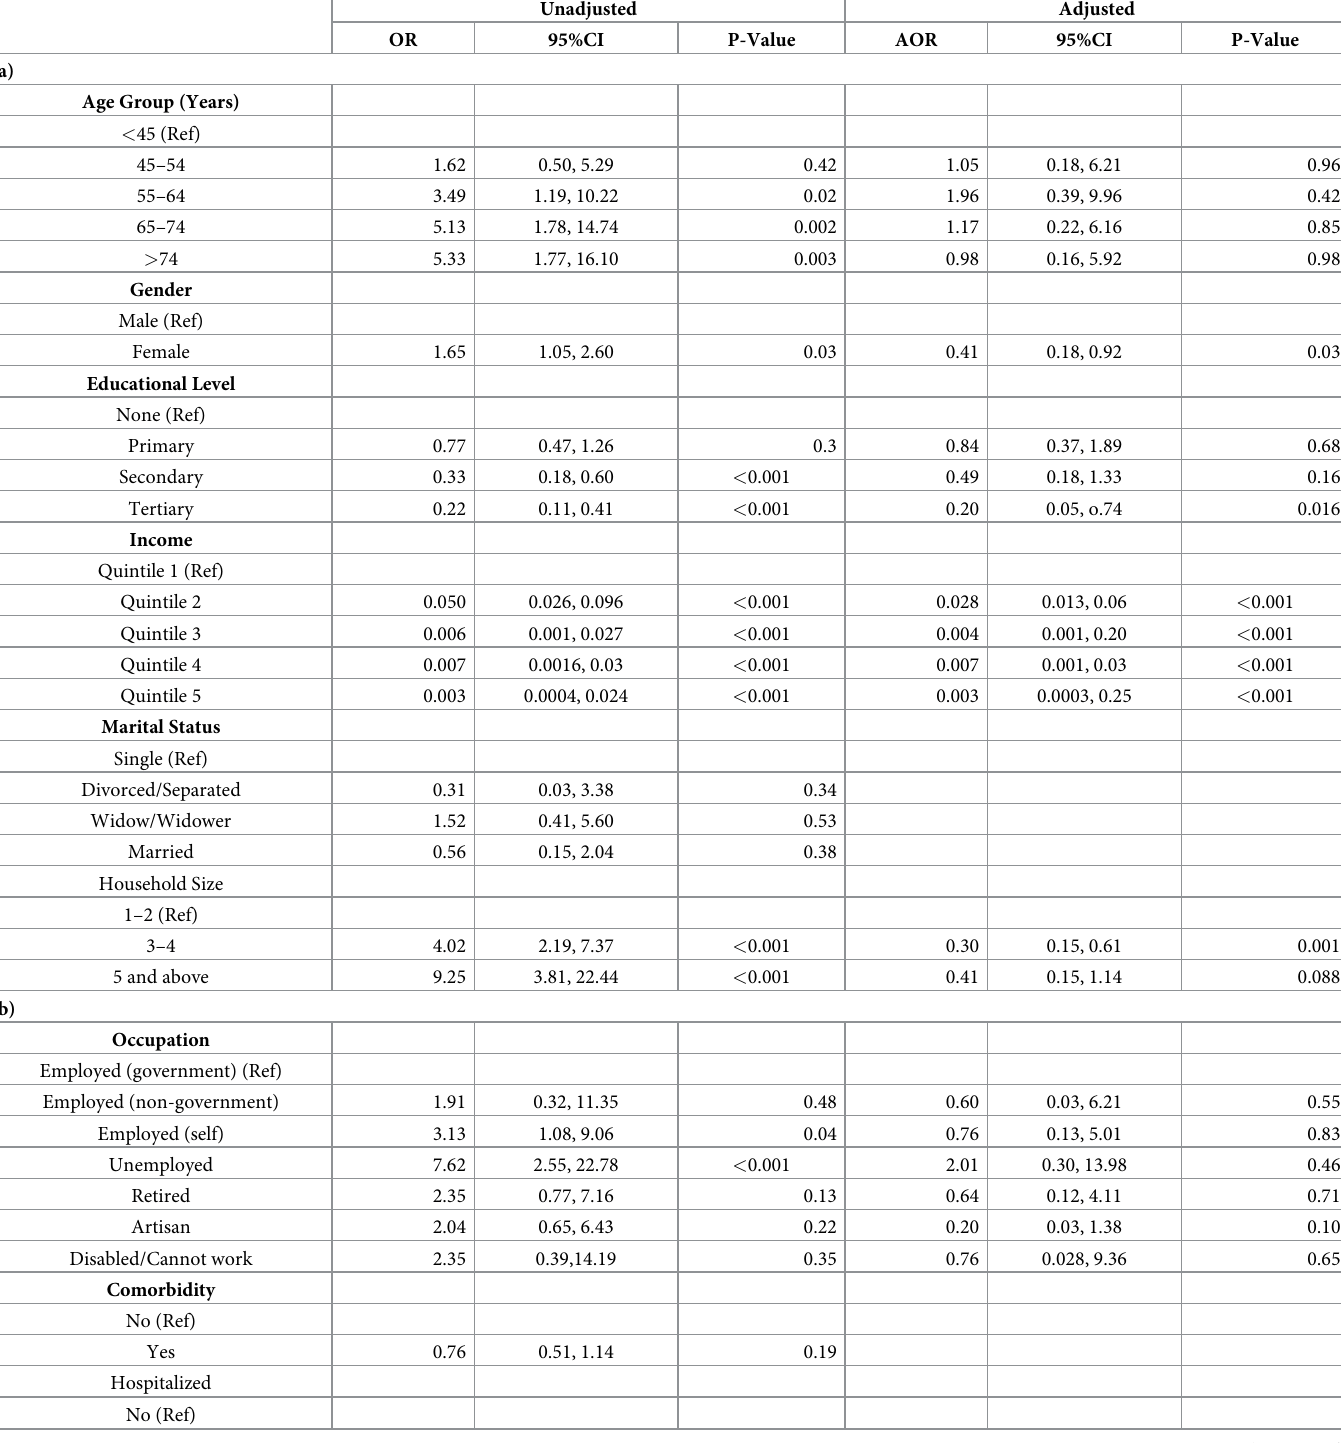
Table 6. Unadjusted and adjusted logistic regression of the factors associated with poverty after accounting for out-of-pocket medical expenditures among CVDs patients accessing healthcare in public and private hospitals in Ibadan (N = 744). Unadjusted Adjusted OR 95%CI